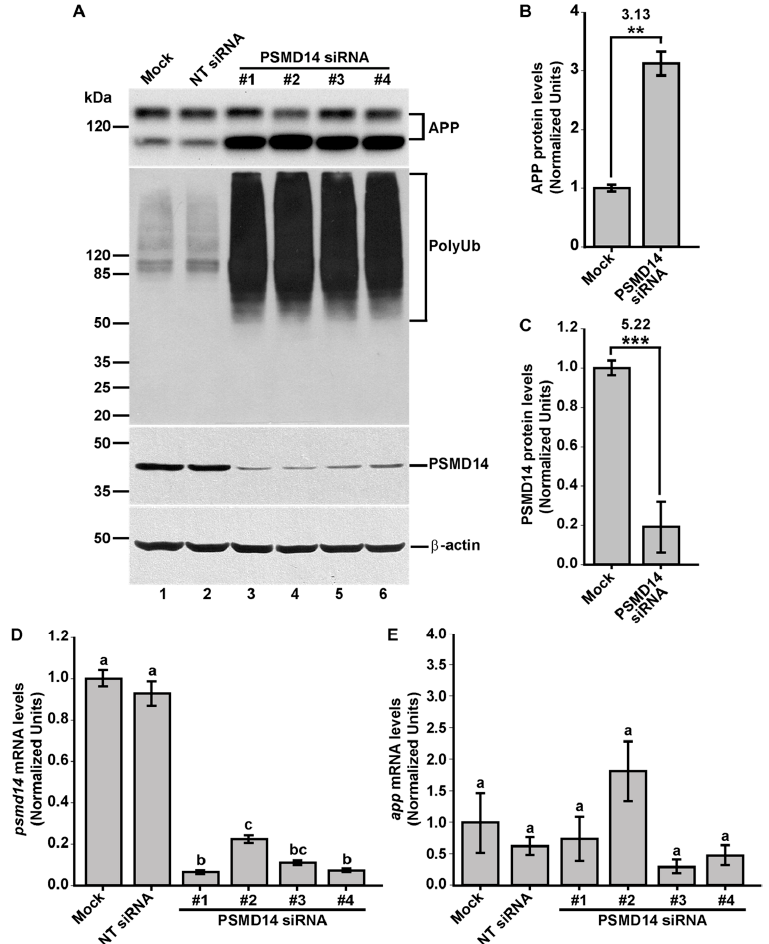
Figure 2. PSMD14 is validated as a regulator of the endogenous APP levels. ( A ) Protein extracts of parental H4 cells either untransfected (Mock), transfected with NT siRNA, or transfected with four different PSMD14 siRNA sequences for 72 h were analyzed by western blot. Polyclonal antibodies to endogenous APP (CT695) and to Ub (that recognizes all types of Ub conjugates), and monoclonal antibodies to PSMD14 (clone D18C7) and to β -actin (clone BA3R), were tested. The position of molecular mass markers are indicated on the left. Densitometric quantification of the levels of endogenous APP ( B ) and PSMD14 ( C ) in H4 cells transfected with PSMD14 siRNA#1, compared to untransfected cells (Mock). Statistical significance was determined by Student’s t-test. Bars represent the mean ± SD of biological replicates (APP n = 5; PSMD14 n = 4). ** p < 0.01 and *** p < 0.001. ( D ) mRNA levels of psmd14 and ( E ) mRNA levels of app were measured using RT-qPCR from parental H4 cells transfected for 72 h. All data were normalized for TATA binding protein expression in either untransfected cells (Mock), cells transfected with NT siRNA or cells transfected with four di ff erent PSMD14 siRNAs duplexes. Statistical significance was determined by One-Way ANOVA, followed by Tukey’s test. Bars represent the mean ± SD of biological replicates ( psmd14 n = 3; app n = 3). Di ff erent letters above the mean bars apply to significant di ff erences between groups p <